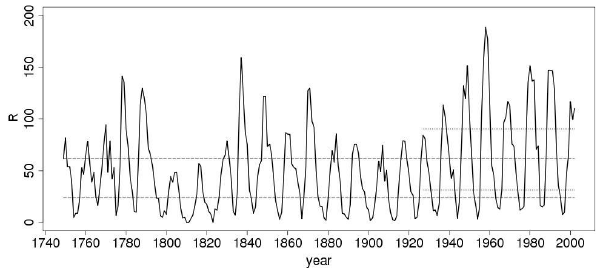
Fig. 2. Evolution of the seasonally-averaged International Sunspot Number ( R ) in late winter (JFM) over the analysed period (1749– 2002). The dashed (dotted) lines mark the thresholds used to define the composites for the surface (upper-air)